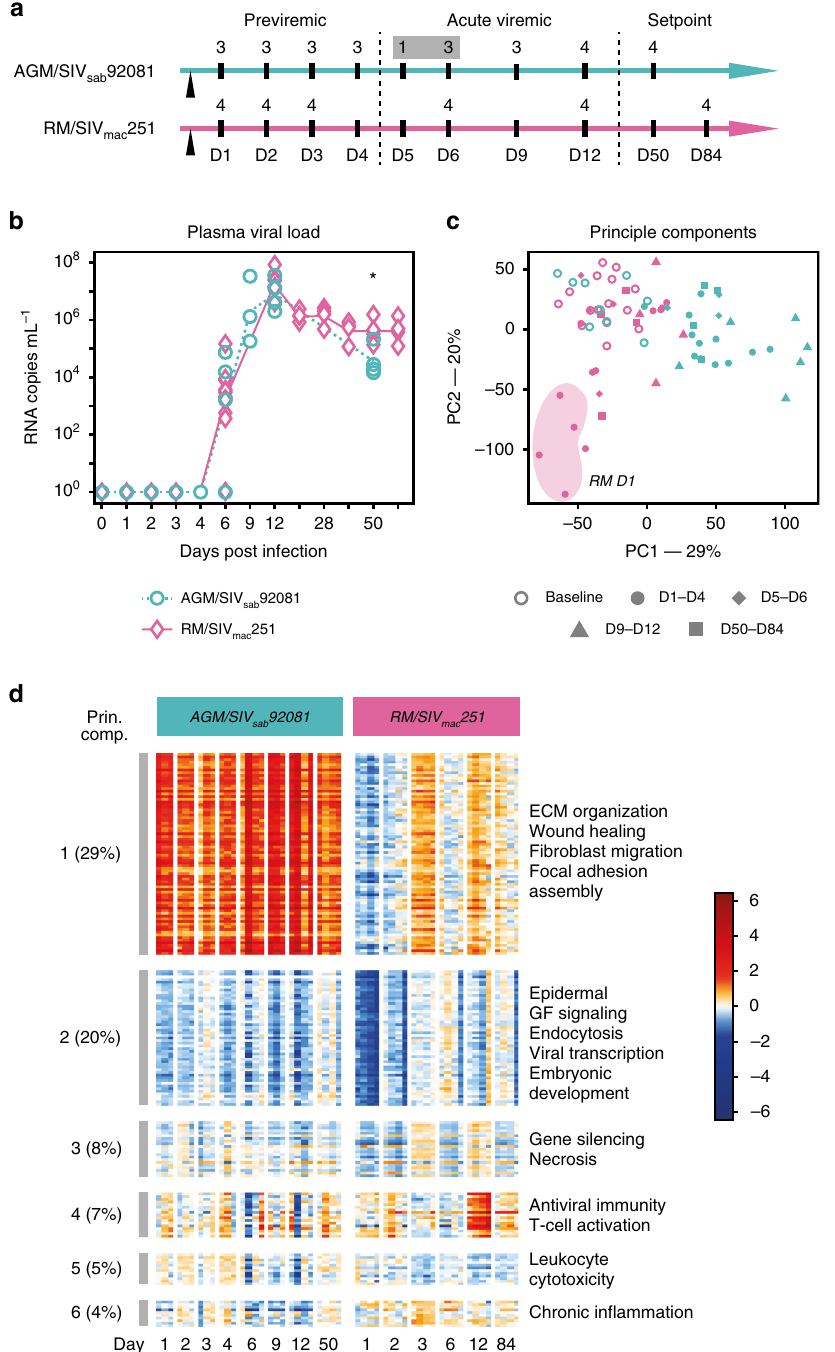
Fig. 1 Study overview. a Study design. Numbers indicate the number of necropsied animals at each time point. b Plasma viral load in AGMs and RMs, given as log 10 values. Signi fi cant difference ( p < 0.05, two-sided T -test) is indicated by a star. c Principle component (PC) analysis of the 7420 DE genes, showing the strongest contrasts between AGM and RM time dynamics. Numbers at the axis indicate the percentage of total variation explained. d Heatmap showing representative gene sets obtained by PC analysis. From the top six principal components, we show the genes with the strongest contribution to variation in proportional numbers. A functional enrichment test was performed on these gene sets; the top enriched functions are listed on the right of